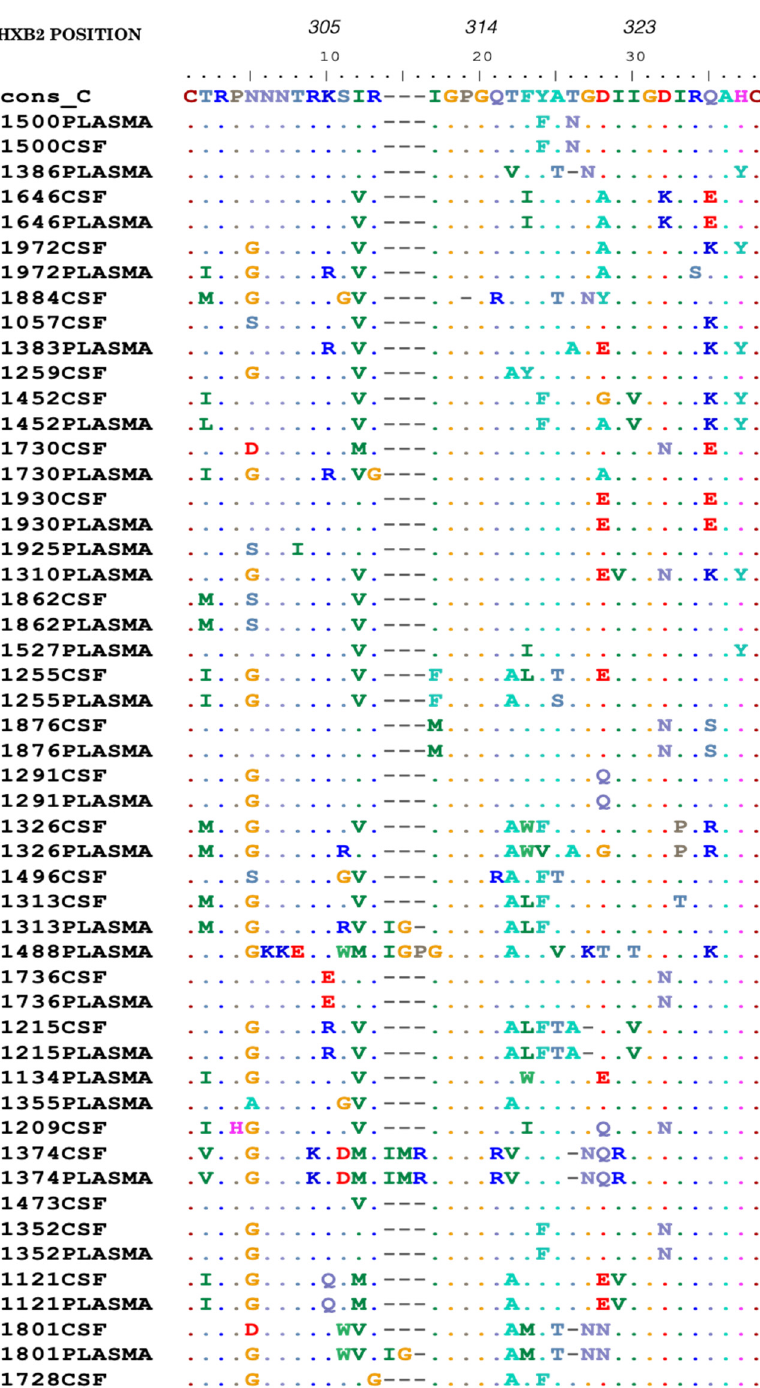
Figure 5. An alignment showing the HIV-1 gp120 V3 amino acids in CSF and plasma. Sequences are numbered relative to HXB2 and the dots represent amino acids identical to the consensus C sequence while dashes represent gaps.